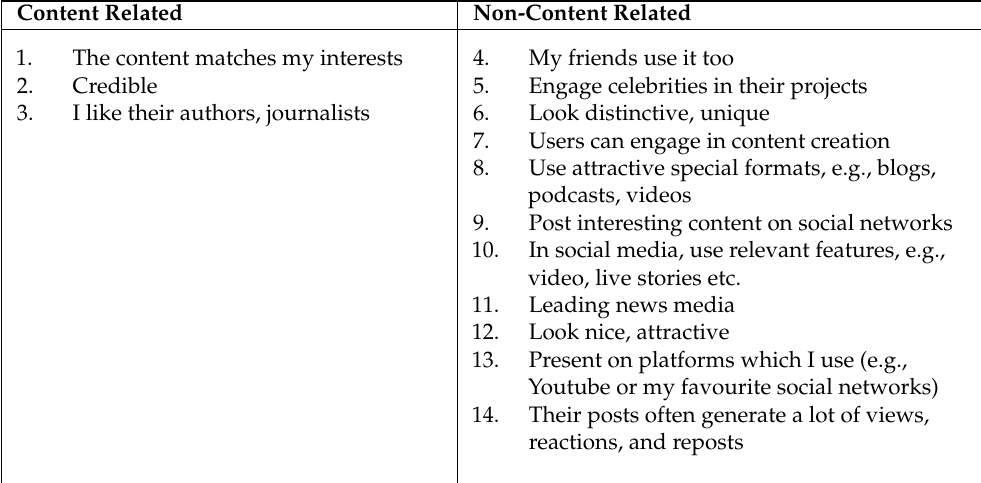
Table 2. The media brand content-related and non-content-related brand